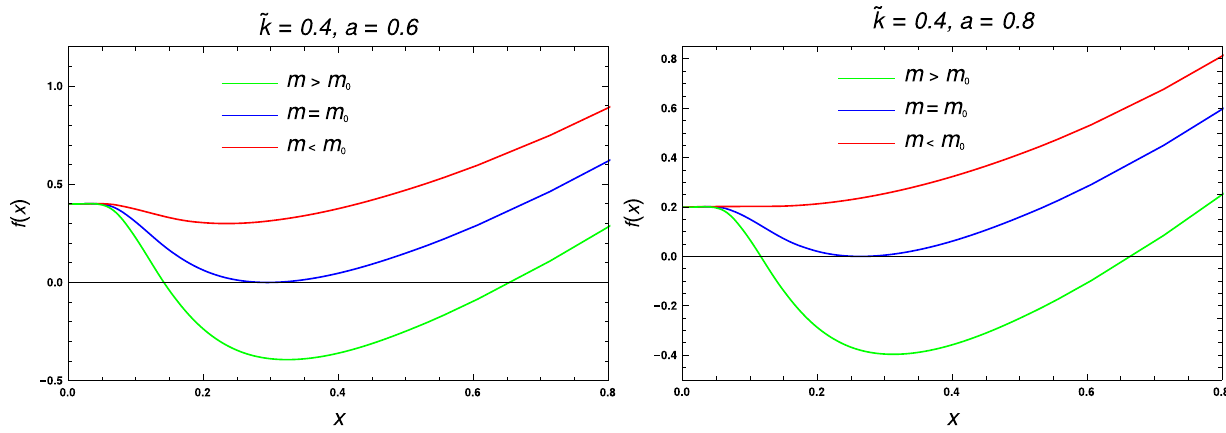
Fig. 2 The metric function f ( x ) vs x . When m = m 0 = 0 . 5039 (left) and m = m 0 = 0 . 16139 (right) corresponding to extremal black hole with degenerate horizon. The black hole with Cauchy and event horizons exist when m > m 0